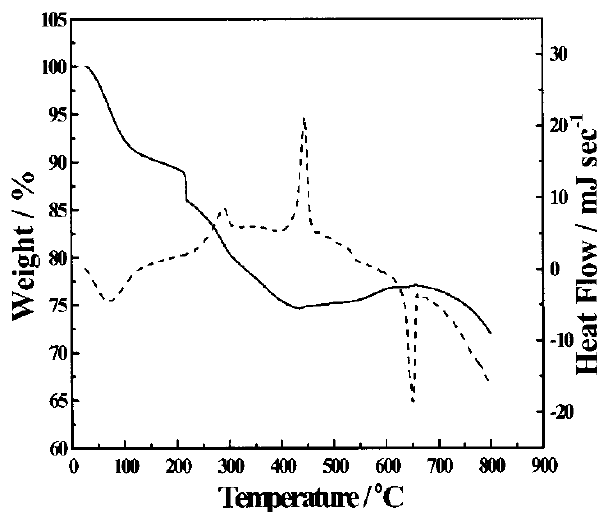
FIGURE 2 Thermogravimetry (solid line) and differential scanning calorimetry (dashed line) curves for VP3 sample as a